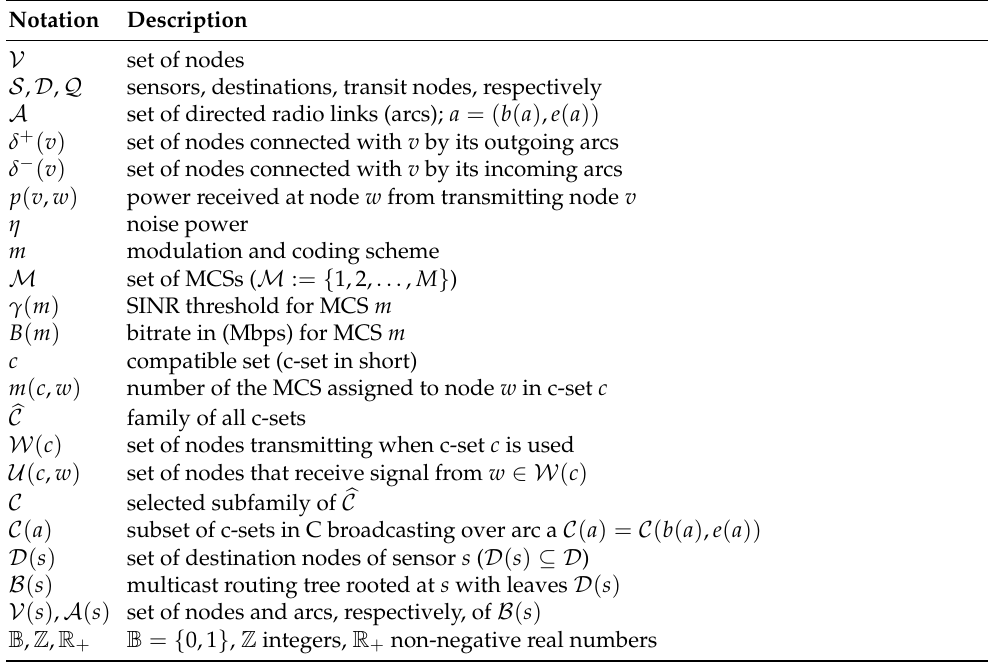
Table 1. Notation: network